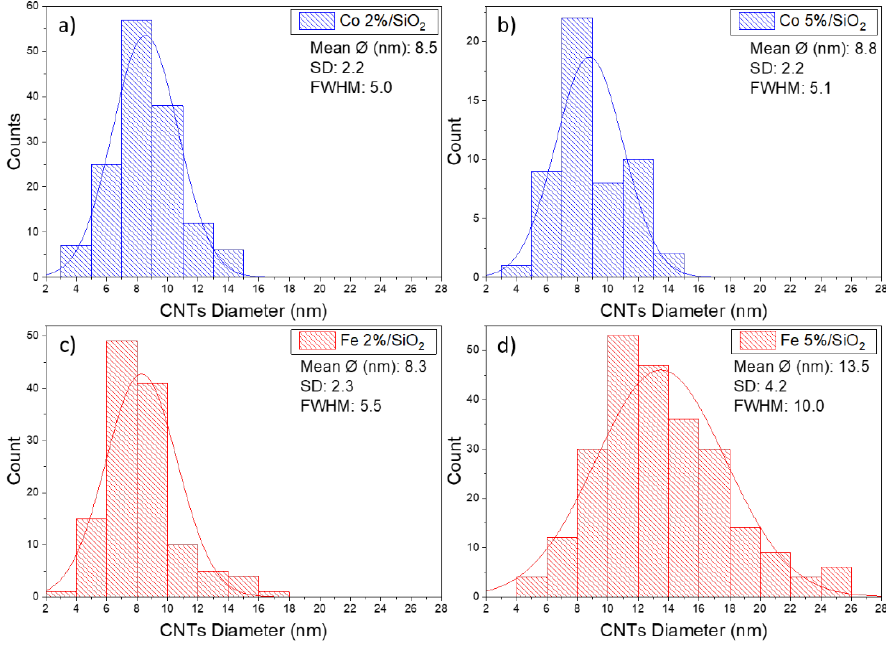
Figure 6. Distribution histograms and corresponding average CNT diameter size for: ( a ) Co 2%, ( b ) Co 5%, ( c ) Fe 2% and ( d ) Fe 5%.